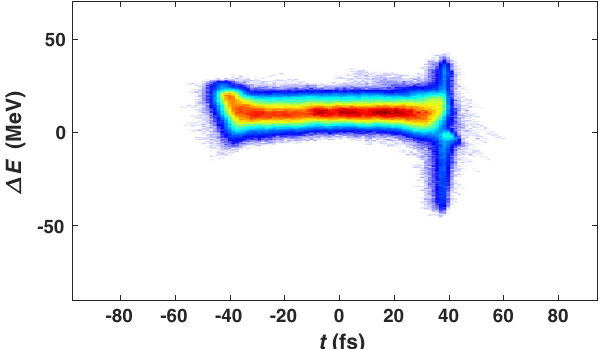
FIG. 15. Sample longitudinal phase space (FEL off) as mea- sured at the CCD screen/camera system following the LCLS X-band transverse deflector. The current was ≈ 1 . 3 kA in the central (cid:2) 35 fs portion of the electron